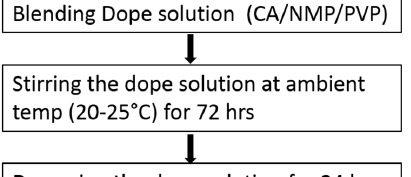
Figure 3. Spinneret type and range of different dimensions used for spinning of CAHF.